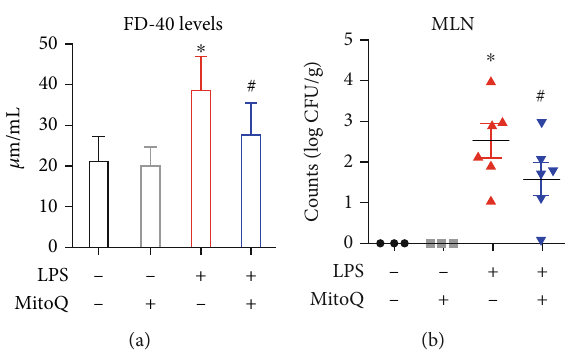
Figure 2: MitoQ improved intestinal permeability and inhibited bacterial translocation during LPS-induce sepsis. (a) Serum FD-40 level was evaluated in vivo permeability. (b) Bacterial CFU was quanti fi ed in MLN, and each data point represents the CFU from each mouse. CFU: bacterial colony-forming units; MLN: mesenteric lymph nodes. Data are expressed as the mean ± SD . ∗ P < 0 : 05 vs. control group; # P < 0 : 05 vs. LPS